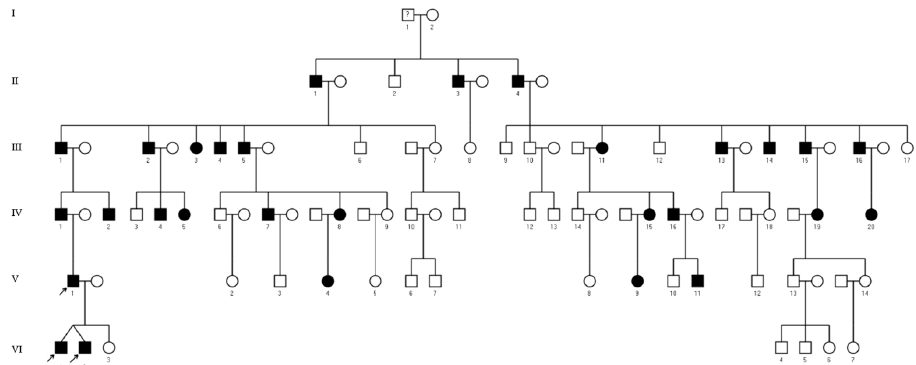
Figure 1. Pedigree with autosomal-dominant SYNS3. Squares and circles indicate males and females, respectively. Roman numerals designate the different generation of the family and latin numerals the individuals in a generation. Affected individuals are indicated by black symbols. Arrows mark the patients described in more detail in this report: patients VI.1., VI.2. and V.1. Information concerning the deceased was not available.